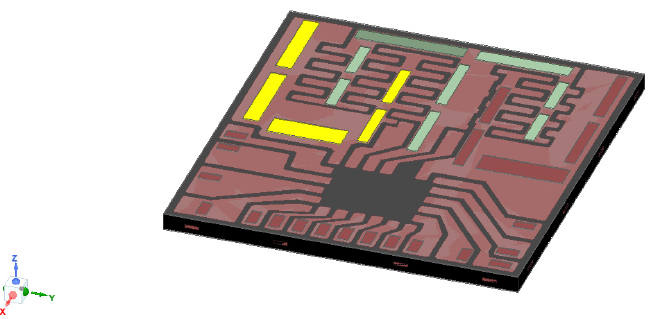
Figure 4. Electromagnetic simulation setup. In yellow, depicted are the ground ports in parallel and in green the switch ports in parallel.